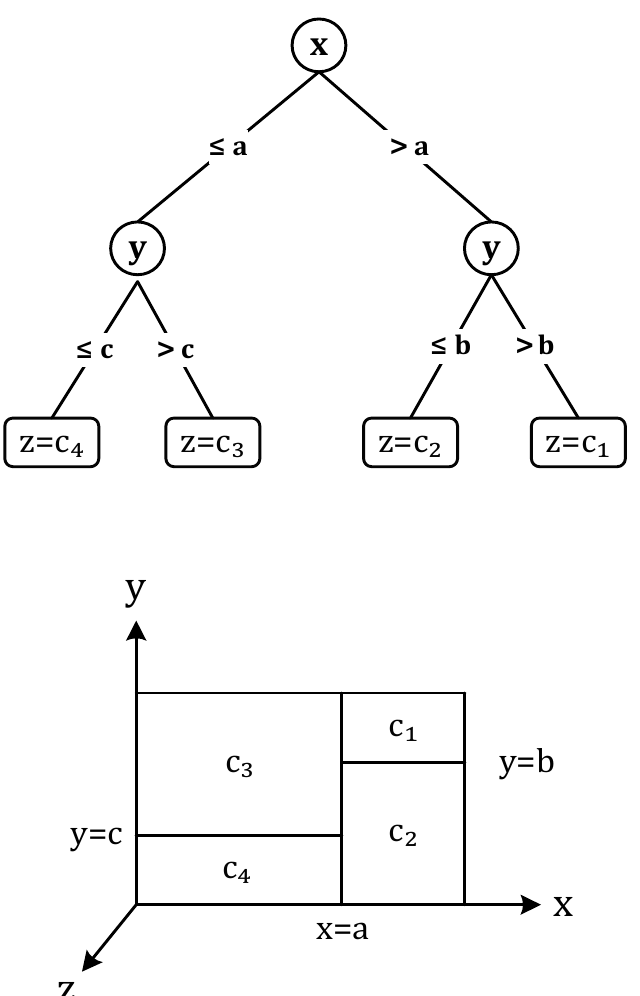
Fig. 1. An example of a decision tree for classification, a) binary decision tree, b) feature space